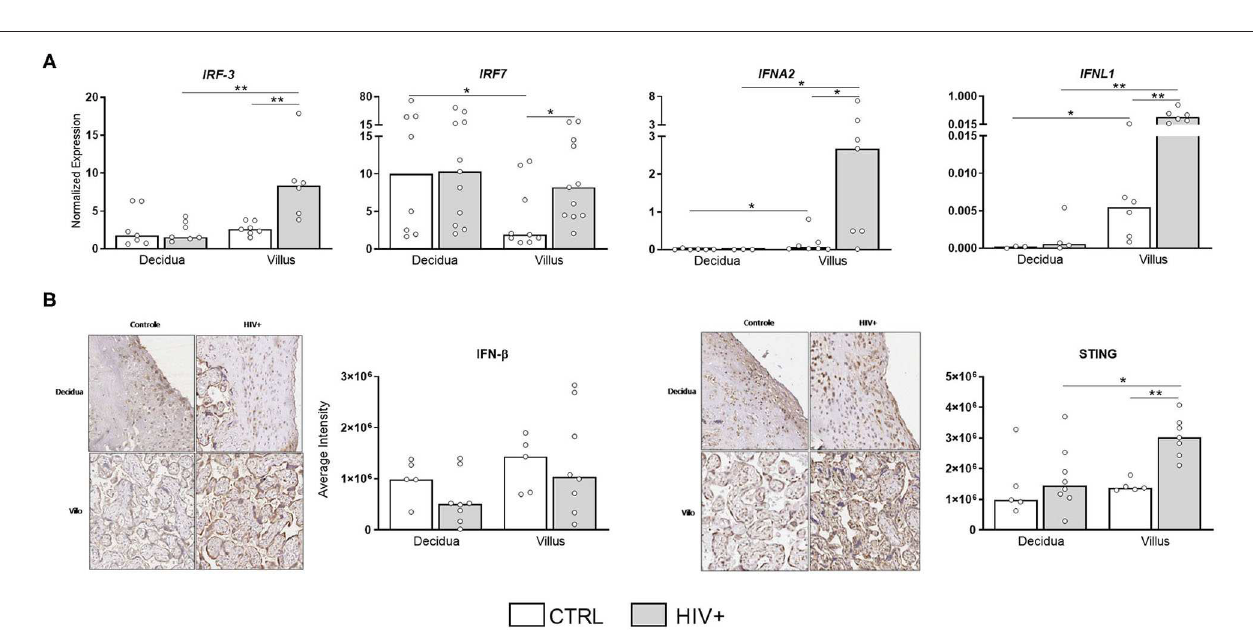
( Figure 4A ), preferentially at villi compartment. STING